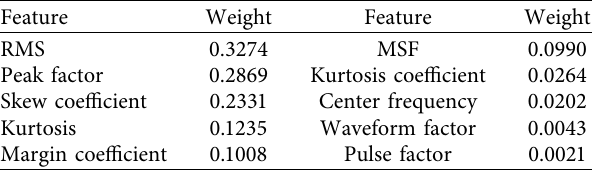
Table 2: Table of characteristic parameter weights.